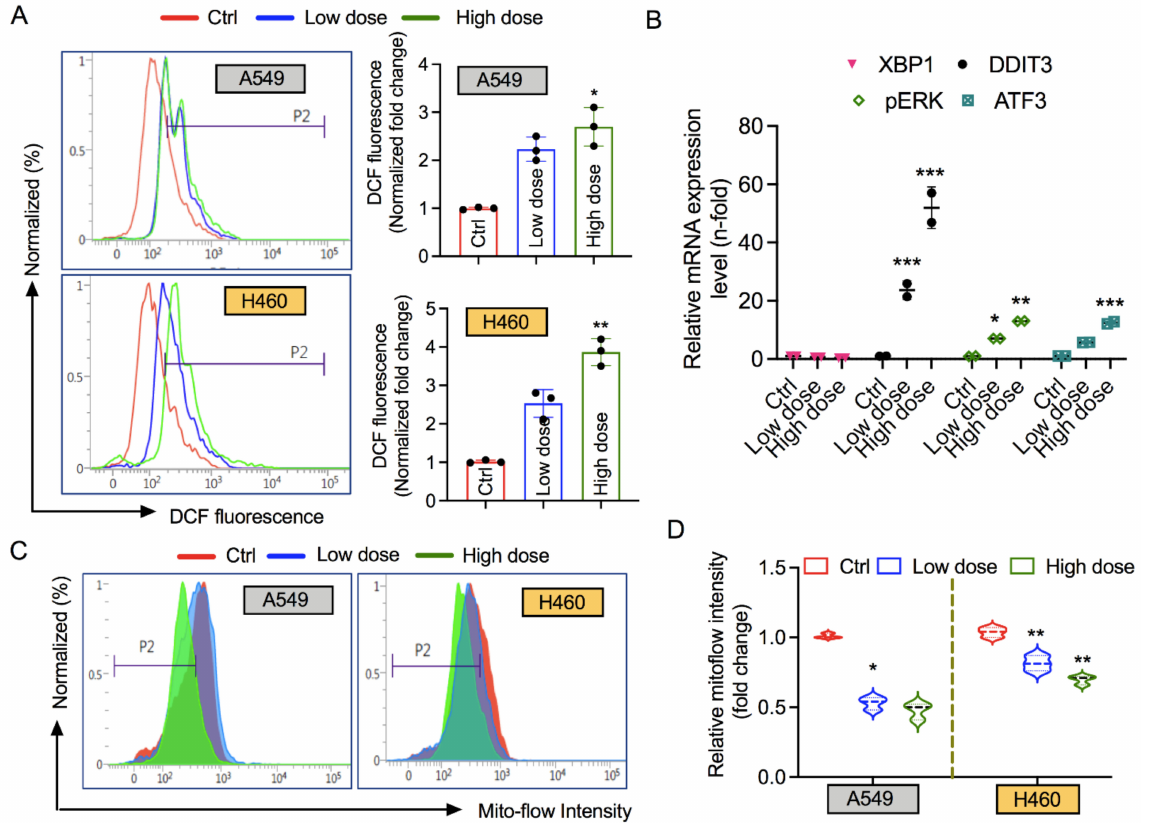
Figure 4. Treatment with 6-aminonicotinamide (6-AN) enhances oxidative and endoplasmic reticulum (ER) stress, and affects mitochondrial membrane potential (MMP) . ( A ) Intracellular reactive oxygen species (ROS) levels were determined in both A540 and H460 cancer cells treated with low (10 µ M) and high (200 µ M) concentrations of 6-AN treatments using flow cytometry. Representative graphs indicate the intensity of DCF fluorescence in 6-AN treated cancer cells normalized to the control. ( B ) qRT-PCR analysis of mRNA expression of ER stress-related genes such as XBP-1, DDIT3, pERK, and ATF3 following 6-AN treatment in H460 cancer cells under both conditions. ( C ) Mitochondrial depolarization levels in A549 and H460 cancer cells following low (10 µ M) and high (200 µ M) concentrations of 6-AN treatments, detected by flow cytometry with the Mitoflow reagent. ( D ) Representative graphs of levels of Mitoflow intensity in A549 and H460 cancer cells, calculated from panel C as per the indicated treatment conditions. * p < 0.05; ** p < 0.01; *** p <